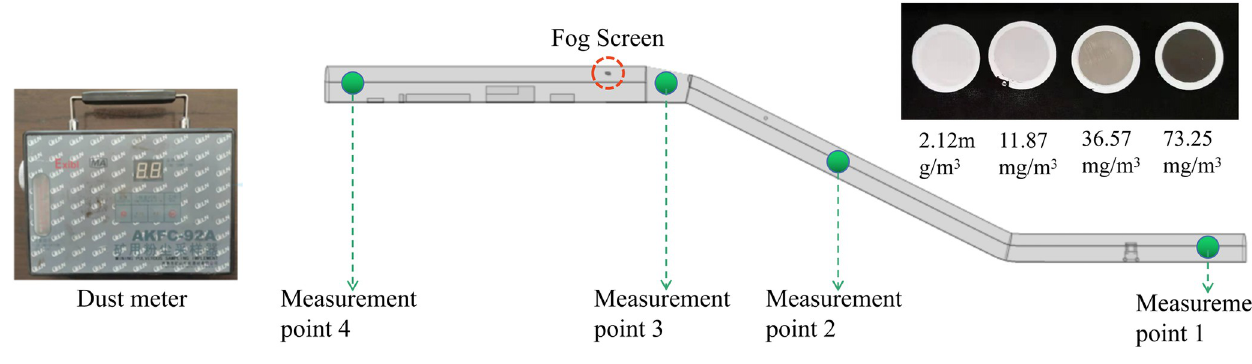
Fig 14. Site plan of measurement points.